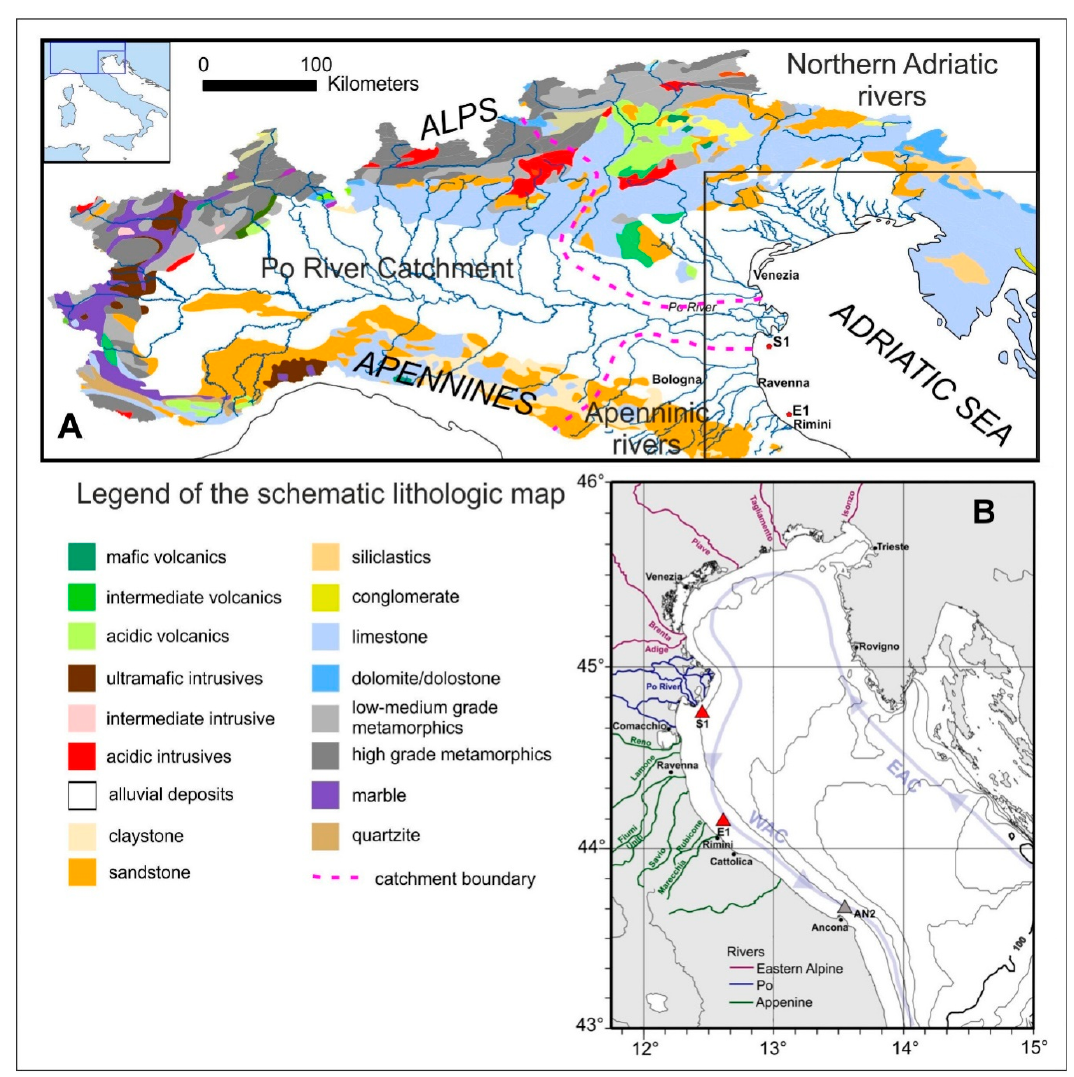
Figure 1. ( A ) Lithologic map of the Po River drainage basin (data from 1:1 Million Surface Geology— European Geological Data Infrastructure: https://egdi ‐ v6.geology.cz/?ak=detailall&uuid=5729ffdf ‐ 2558 ‐ 48fc ‐ a5d2 ‐ 645a0a010855). Major Po contributor rivers are also indicated. ( B ) Schematic surface circulation pattern of the Northern Adriatic Sea. EAC, Eastern Adriatic Current; WAC, Western Adriatic Current [9]. Triangles represent S1, E1 (this work, red triangles) and AN2 (grey triangle) [10] coring sites.